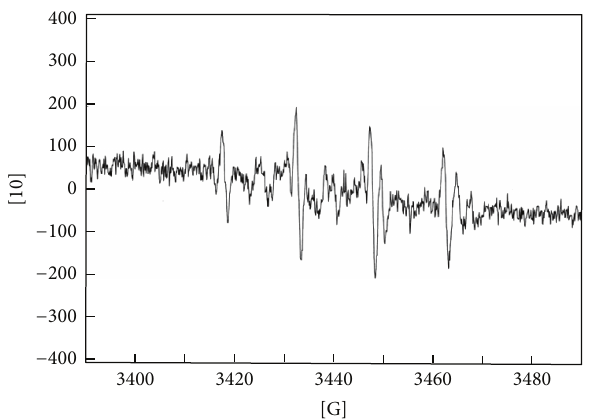
Figure 1: ESR spectra of DMPO-OH spin-adduct model system in the presence of ethyl-acetate extract of soybean irradiated with 10 kGy.